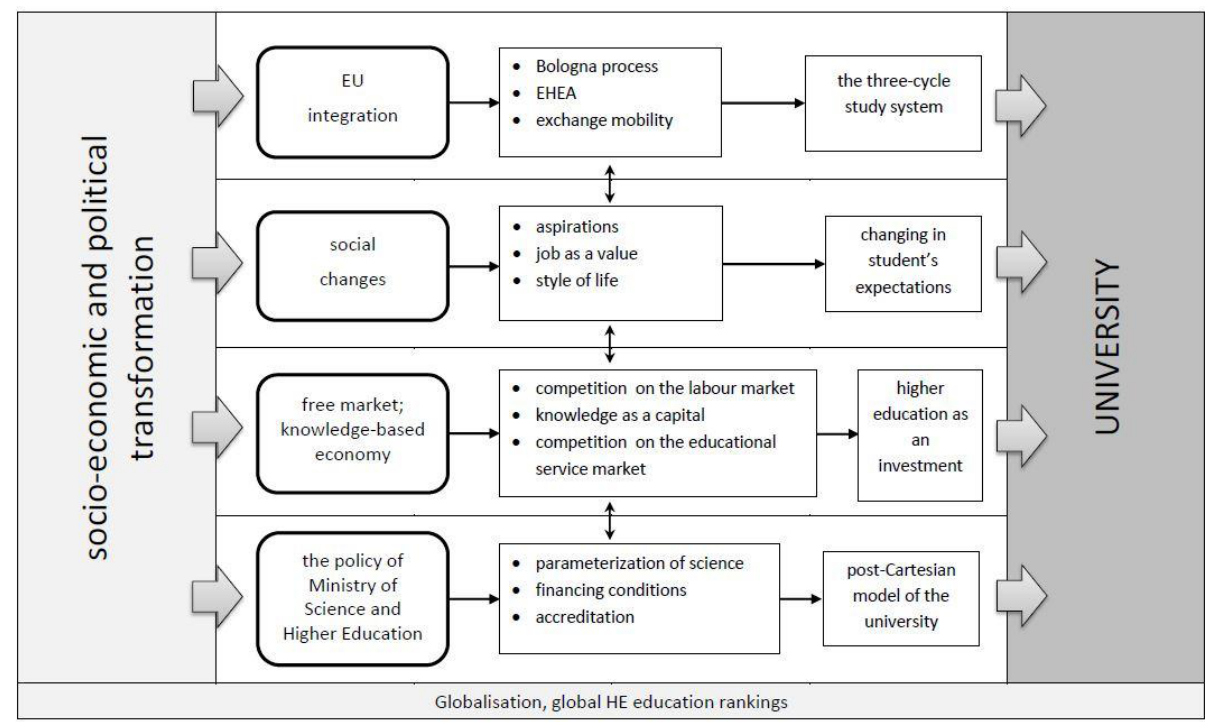
Fig. 1. Processes determining the operation of the university in the 21st century (author’s own